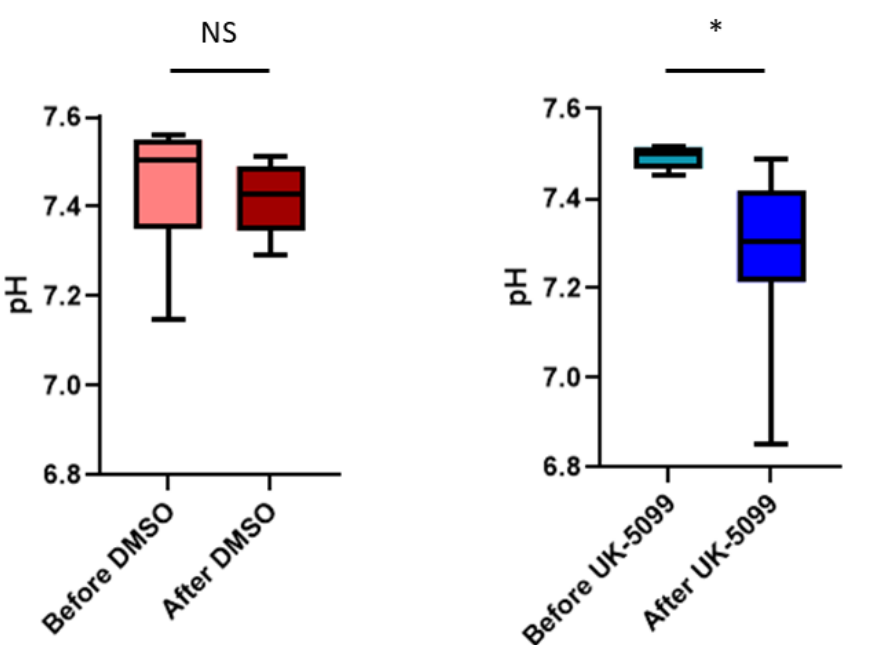
Figure 6. Evolution of pHe (estimated by CEST-MRI) in 4T1 tumors in mice before and after treatment